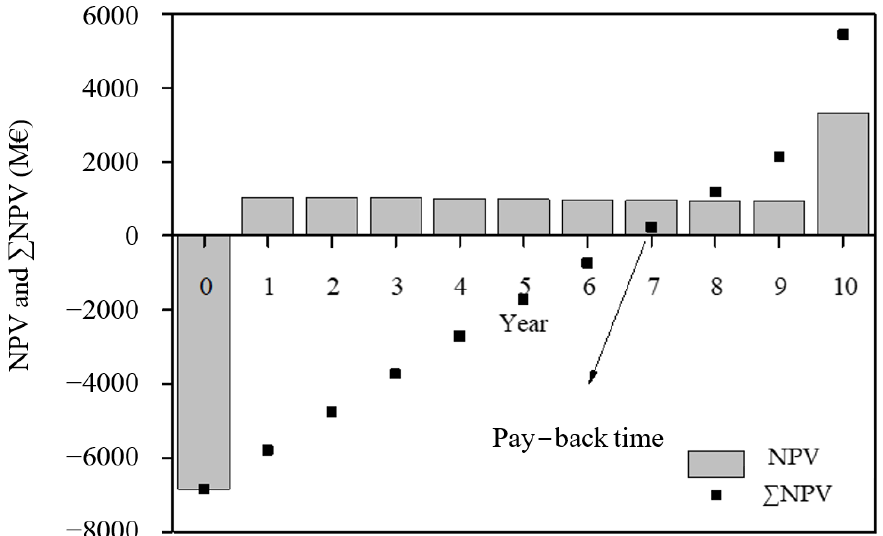
Figure 7. Annual cash flows of the plant.